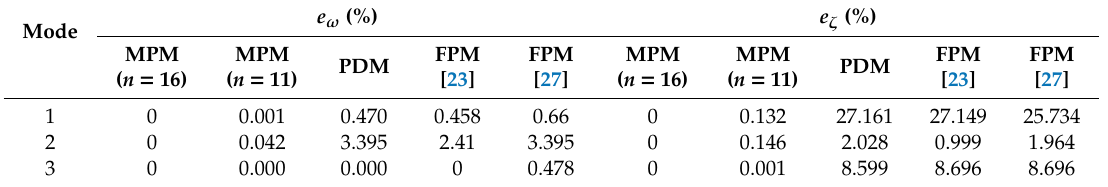
Table 6. The errors of natural frequencies and damping ratios of the frame